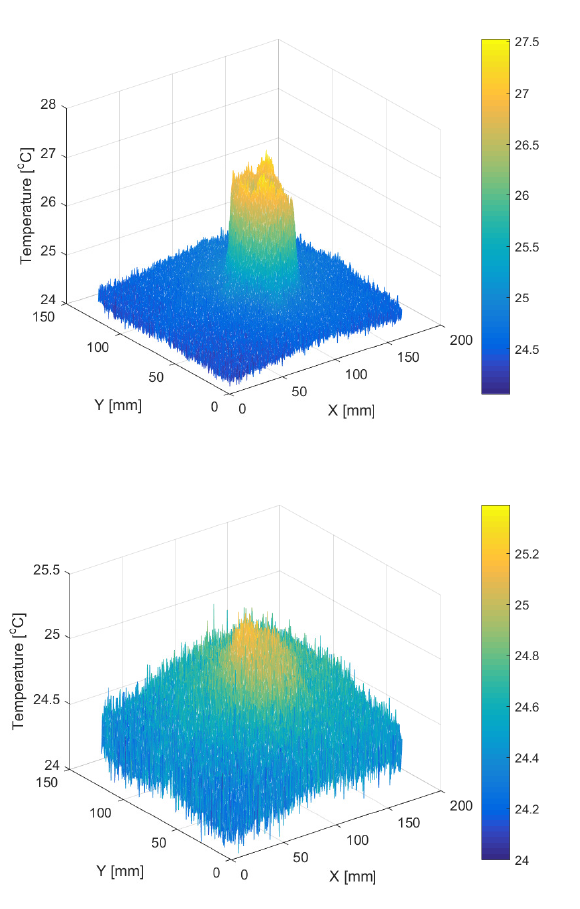
Figure 2. 3D diagrams of thermal traces for the initial ( top ) and final ( bottom ) time points. Dimen- sions X and Y in